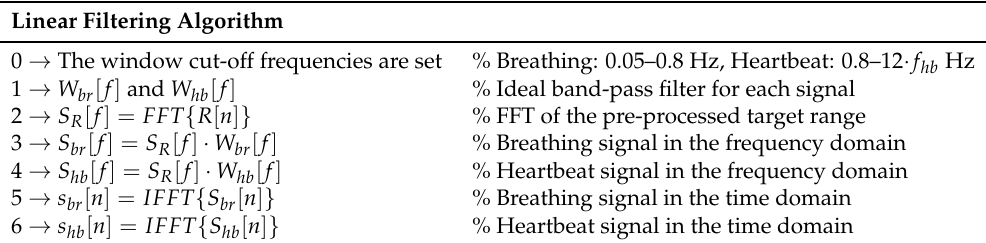
Table 5. Linear filtering algorithm steps.